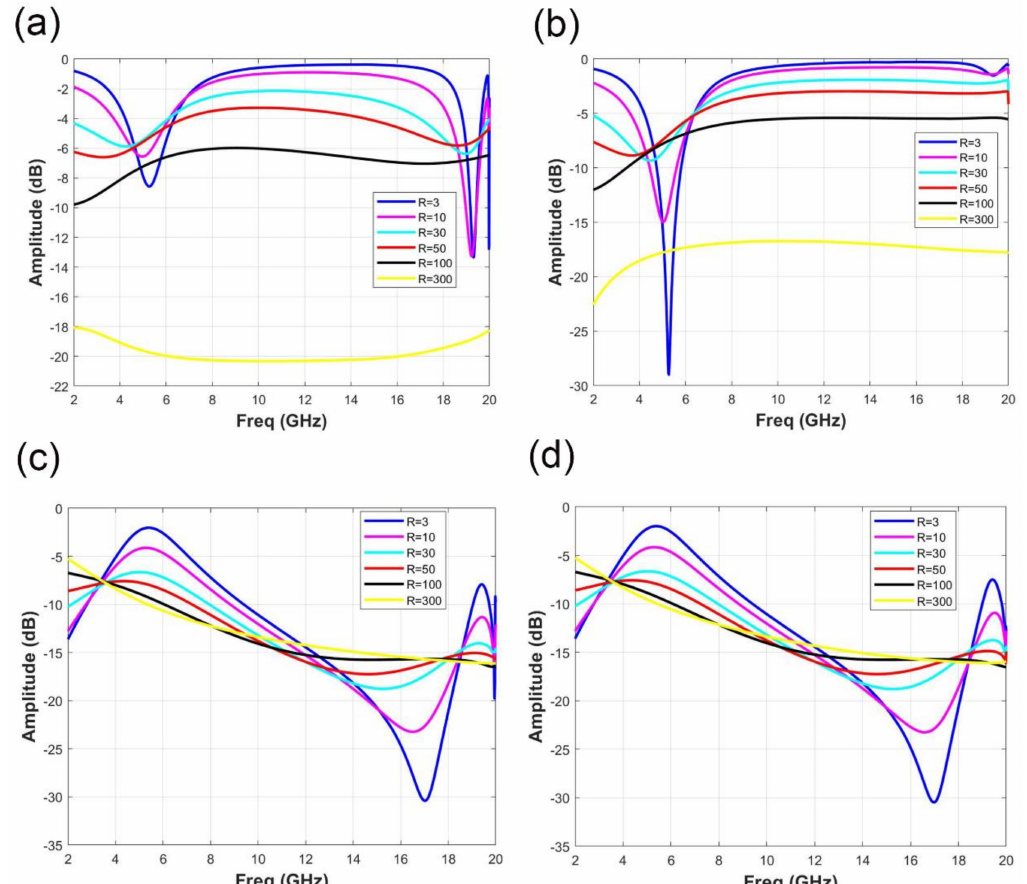
Figure 4. Variation of reflection coe ffi cient S11 and transmission coe ffi cient S21 under di ff erent polarization modes when R changes. ( a ) Variation of the reflection coe ffi cient S11 under x polarization when R changes. ( b ) Variation of the reflection coe ffi cient S11 under y polarization when R changes. ( c ) Variation of transmission coe ffi cient S21 under x polarization when R changes. ( d ) Variation of transmission coe ffi cient S21 under y polarization when R